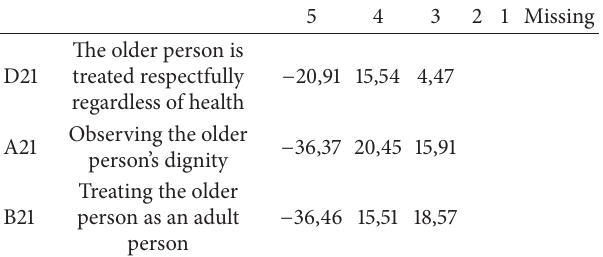
Table 10: Effects on distribution function when E21 fixed to “4” =